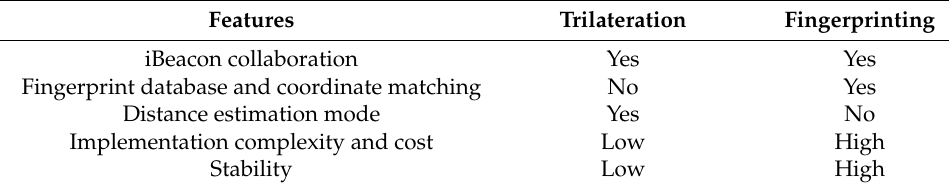
Table 1. Trilateration and